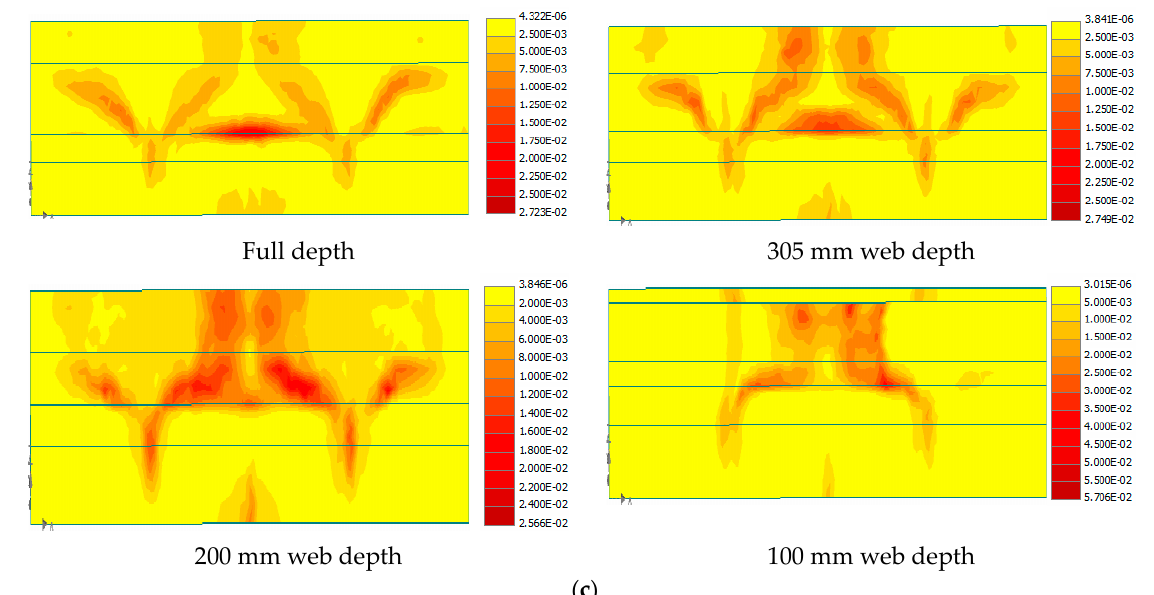
Figure 13. Crack patterns, crack width, and principal tensile strain of 0° skewed beam: ( a ) Crack pattern (0° skew); ( b ) Crack width (0° skew); ( c ) Principal tensile strain (0° skew).